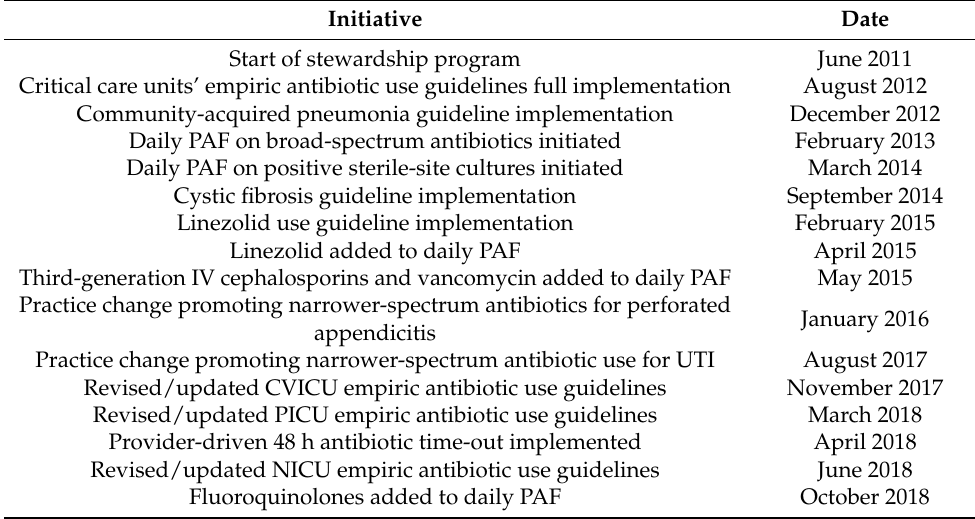
Table 1. ASP initiatives